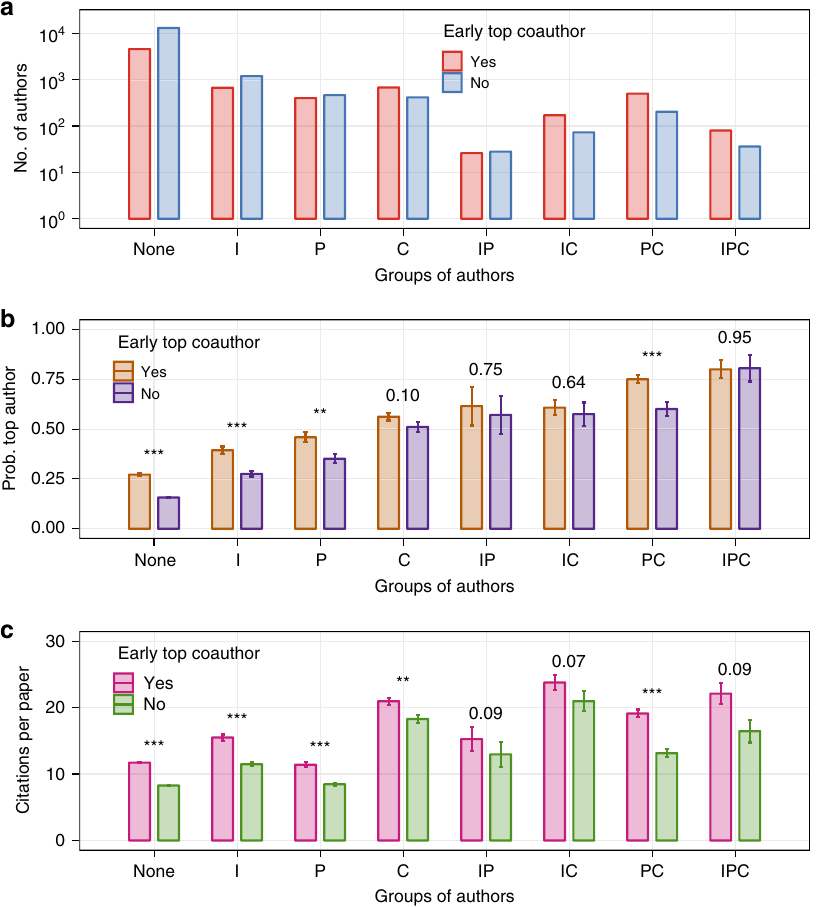
Fig. 2 Relationship between long-term impact and early career performance. a Number of junior researchers belonging to the top 10% in various categories of early career performance (I denotes institutional prestige, P denotes productivity, and C denotes citations received. All three such quantities are computed based on the fi rst 3 career years). b Probability for authors belonging to each group of being a top scientist in their 20th career year. c Number of citations received per paper published by authors belonging to each group between their 4th and 20th career year. In b and c we report 95% con fi dence intervals, and we report the p -values obtained via t -tests to assess the statistical signi fi cance of differences between the sub-group of junior researchers who coauthor work with a top scientist in the fi rst 3 career years and the sub-group of those who do not. (cid:1) p < 0 : 05; (cid:1)(cid:1) p < 0 : 01; (cid:1)(cid:1)(cid:1) p < 0 :